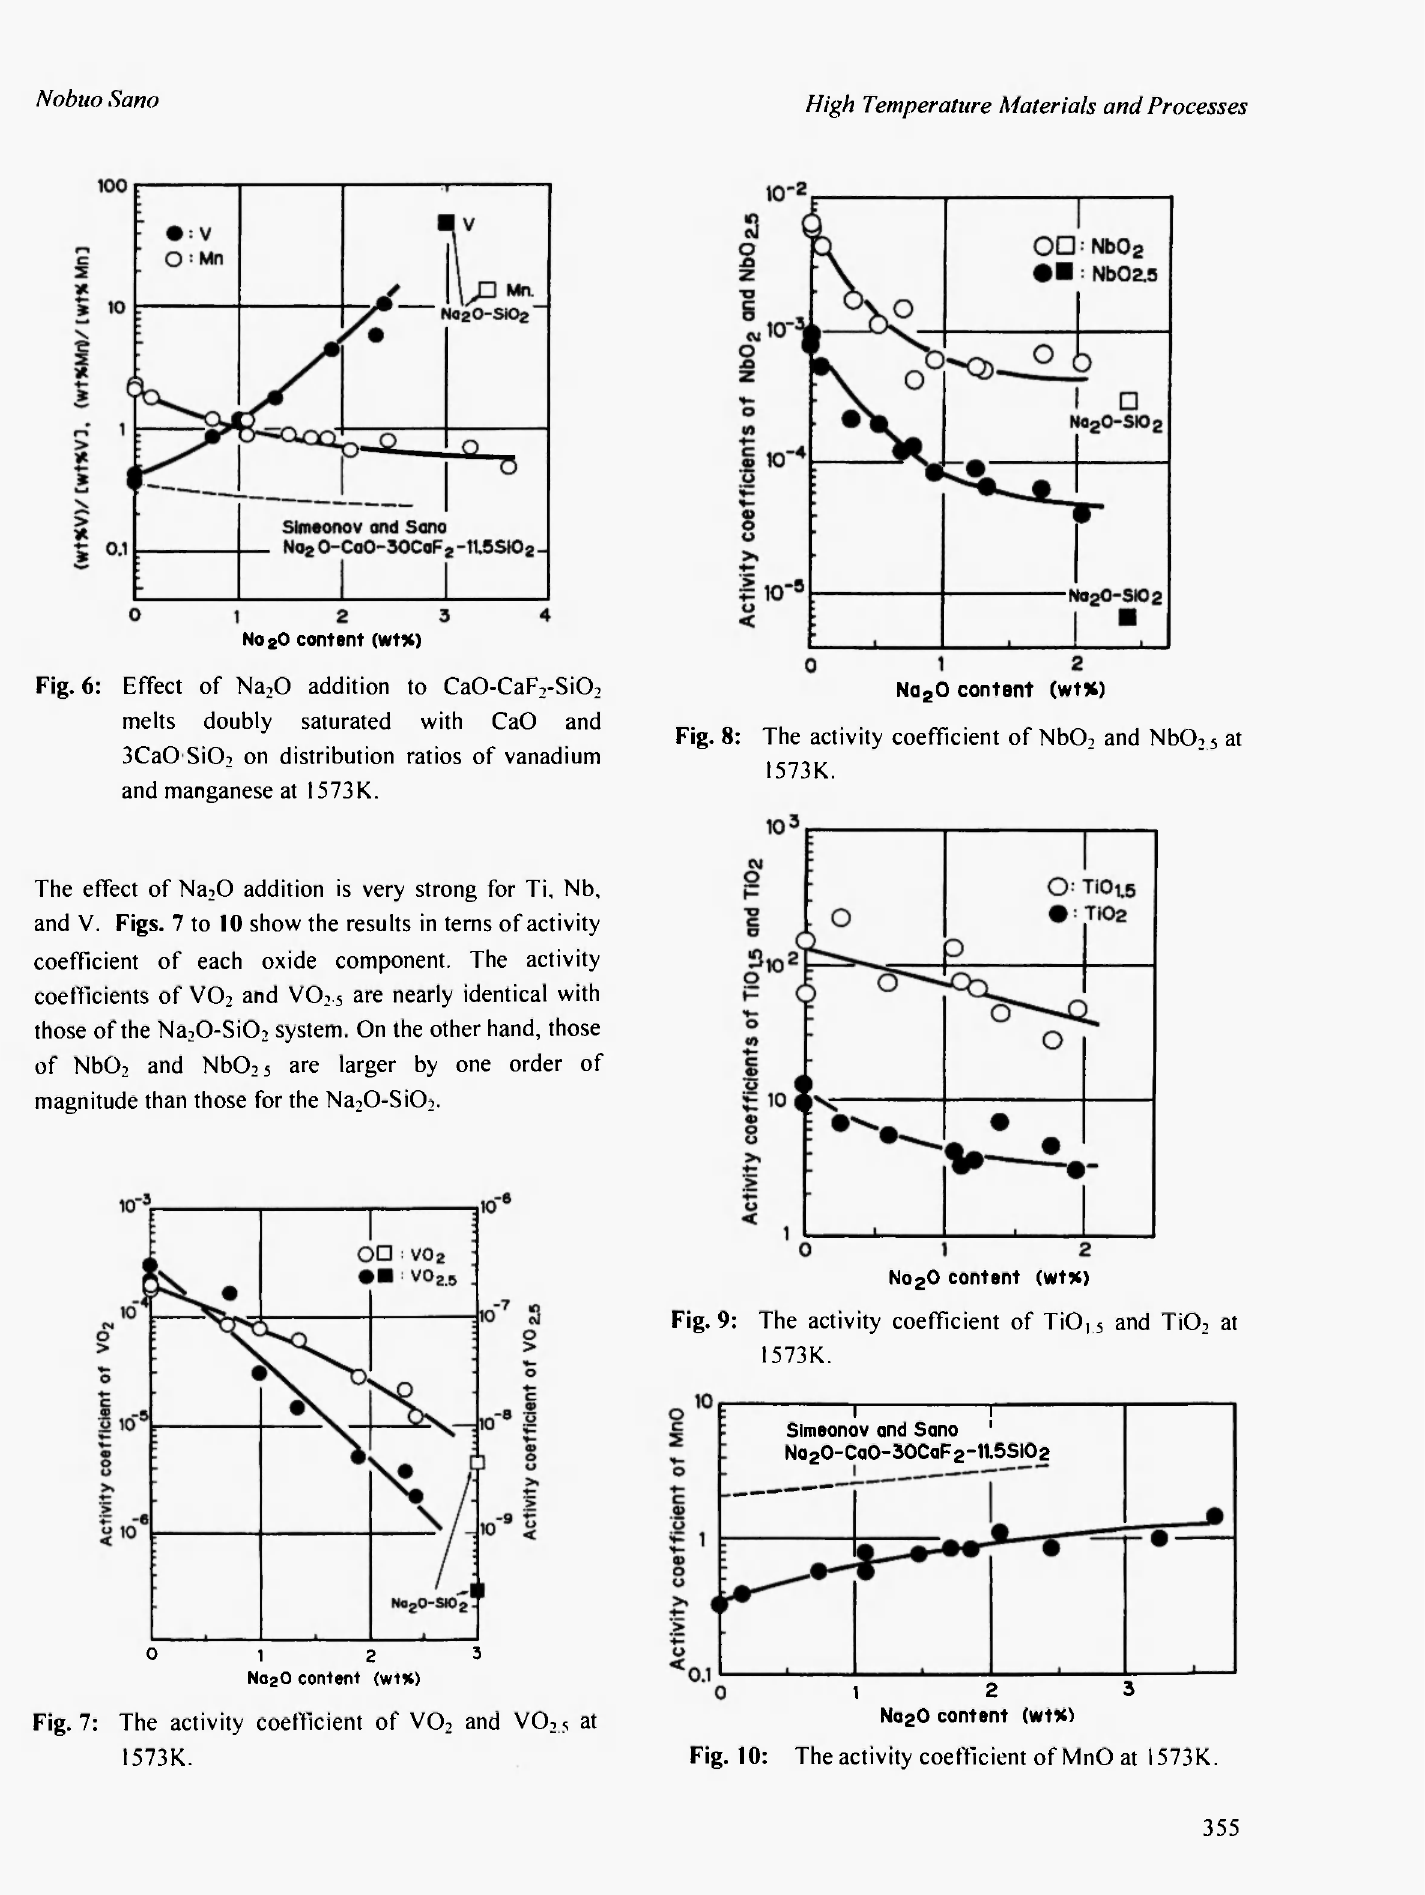
Fig. 9: The activity coefficient of TiO, 5 and Ti0 2 at